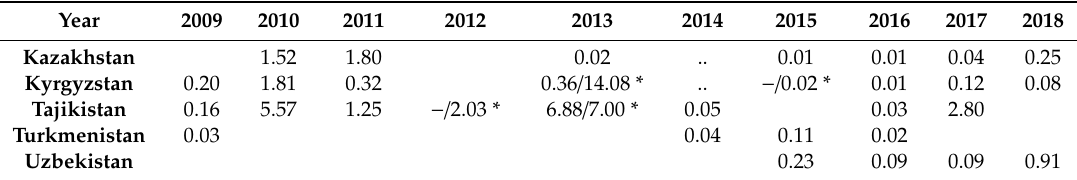
Table A4. ODA in NHRE in Central Asian Economies, US$ mn (Source: author, based on Creditor